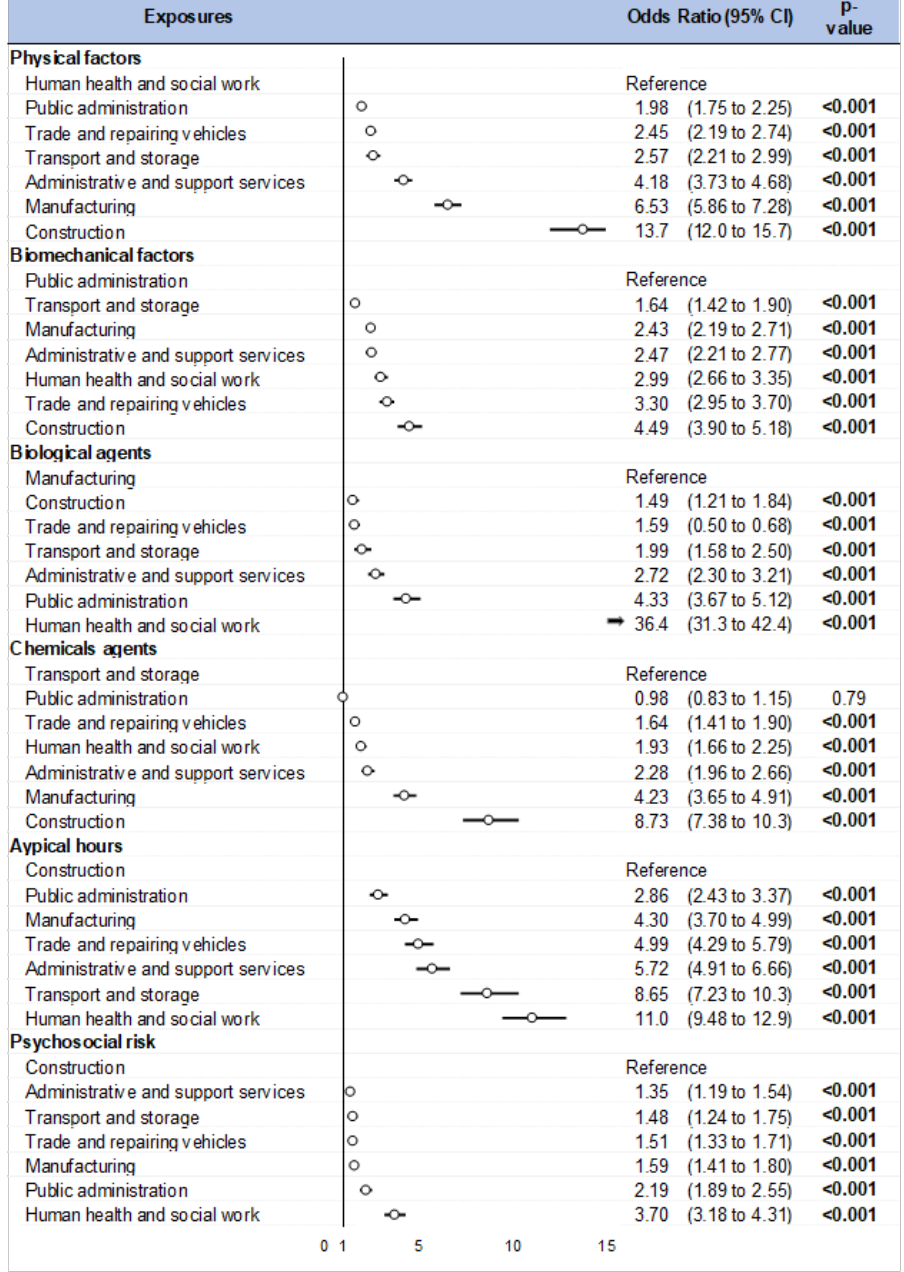
Figure 4. Forest plot: Sector by risk. Note: The circle represents the point estimates for each sector and the horizontal lines indicate the confidence intervals around the point estimates. The vertical line indicates the null effect, which is the point at which the odds ratio equals one. If the confidence interval for a sector crosses the vertical line, it suggests that the odds ratio is not statistically significant. For some sectors, an arrow indicates that the point estimate is outside the range of the plot and the circle is cut off.